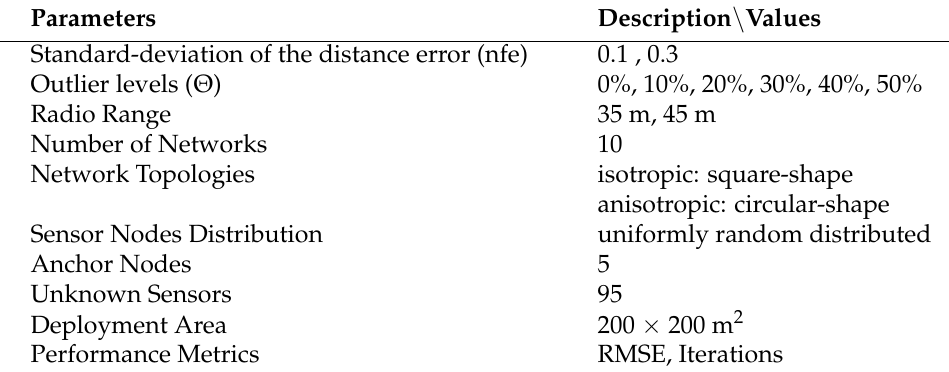
Figure 2. Methodology followed to test RMSEavg and Iter _ avg spent by algorithms using a setup of 10 networks for both circular and uniform node distributions. Table 1. Simulation parameters of the